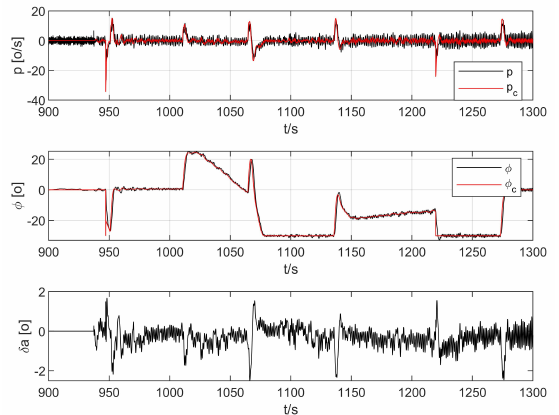
Figure 32. Flight test data. Command and response value of the roll